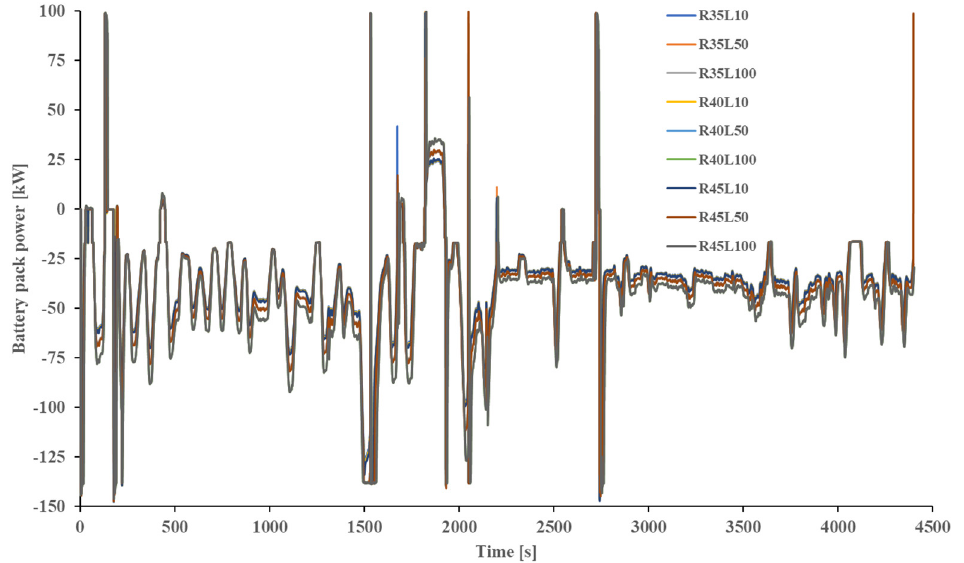
Figure 13. The battery pack power variations during travel for different scenarios.